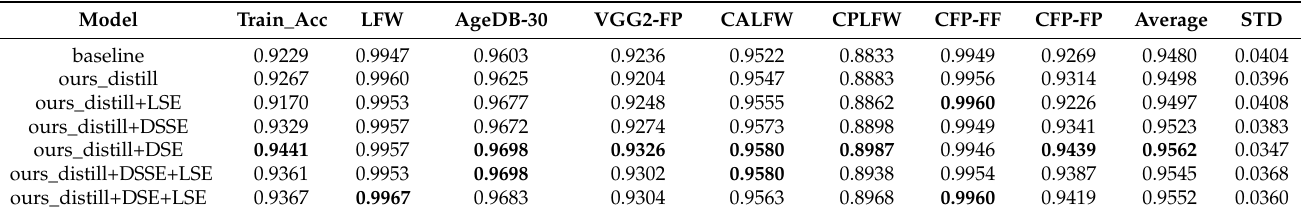
Table 5. The test results of the models with different modules in the proposed training pattern. The data in the columns of LFW, AgeDB-30, VGG2-FP, CALFW, CPLFW, CFP-FF, and CFP-FP represent the accuracy of the model on different test sets. These test sets are described in detail in Section 4.1. Bold is to highlight the optimal value of each column, making it more obvious and impressive.